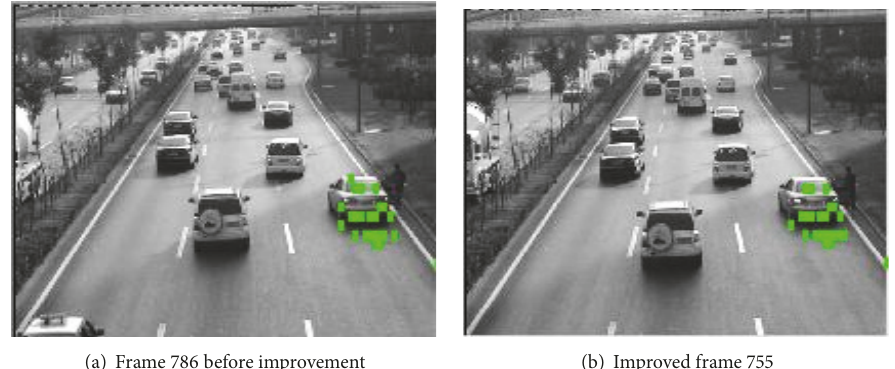
Figure 22: Comparison of the effect of detecting